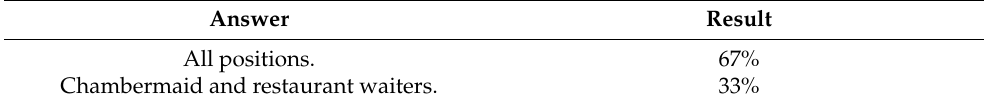
Table 6. What positions do your workers with disabilities usually occupy? Answer Result All positions. 67% Chambermaid and restaurant waiters.